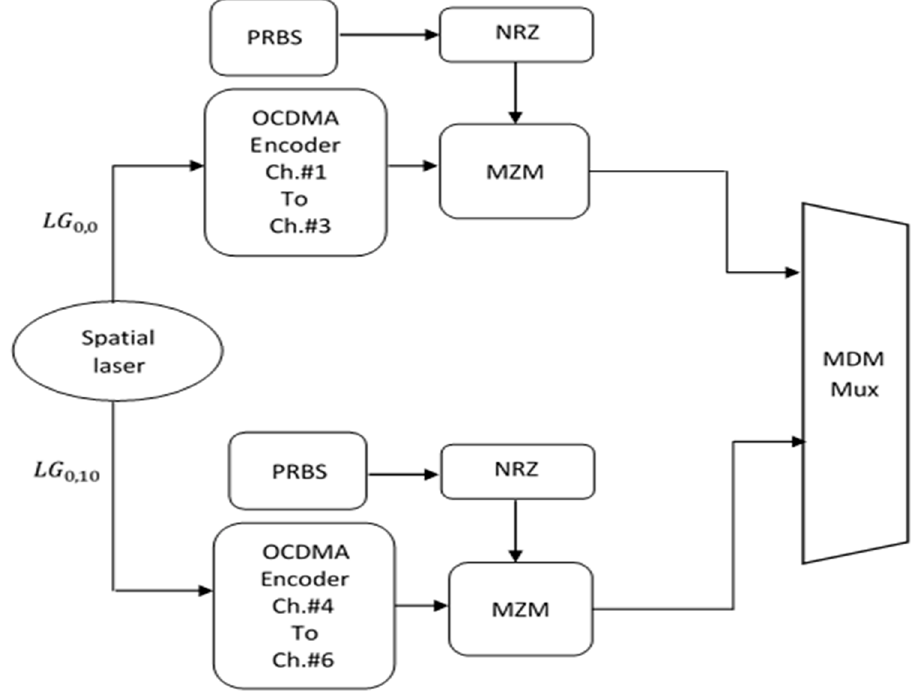
Figure 3. Block diagram demonstrating the transmitter of the OAM/OCDMA-FSO system (MZM: Mach–Zehnder modulator; PRBS: pseudorandom bit sequence). Mach–Zehnder modulator; PRBS: pseudorandom bit